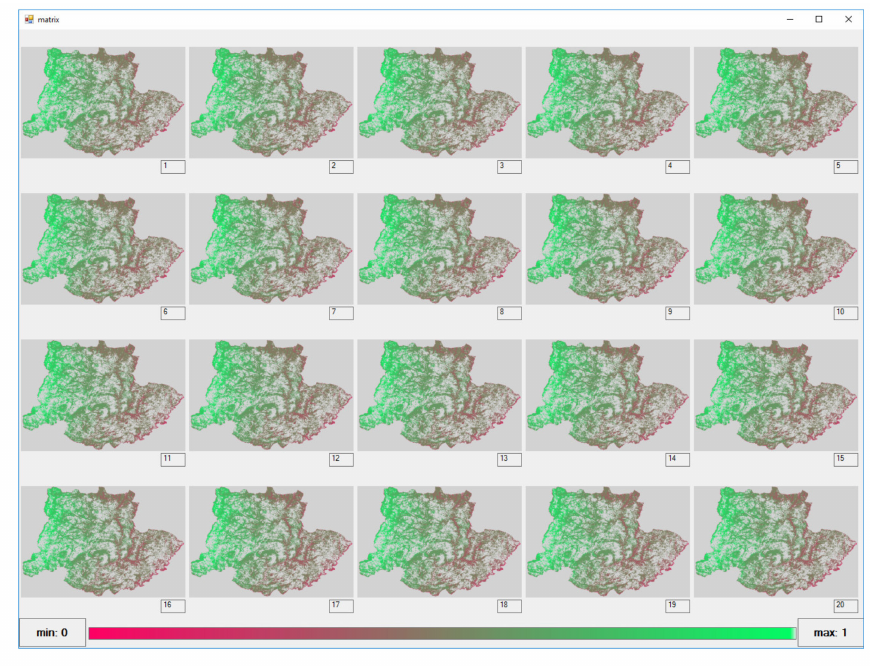
Figure A1. Value distribution (on a 0 to 1 scale) for Biomass I (B 1 ) over a period of 20 years (t 1 to t 20 ) in the Nordeste region, Portugal. Light green cells indicate higher suitability and light red cells lower suitability of forest units for industry.